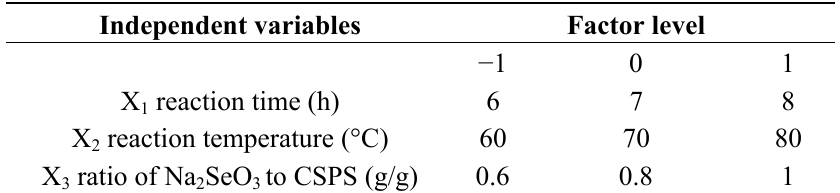
Table 5. Independent variables and their levels used in the response surface